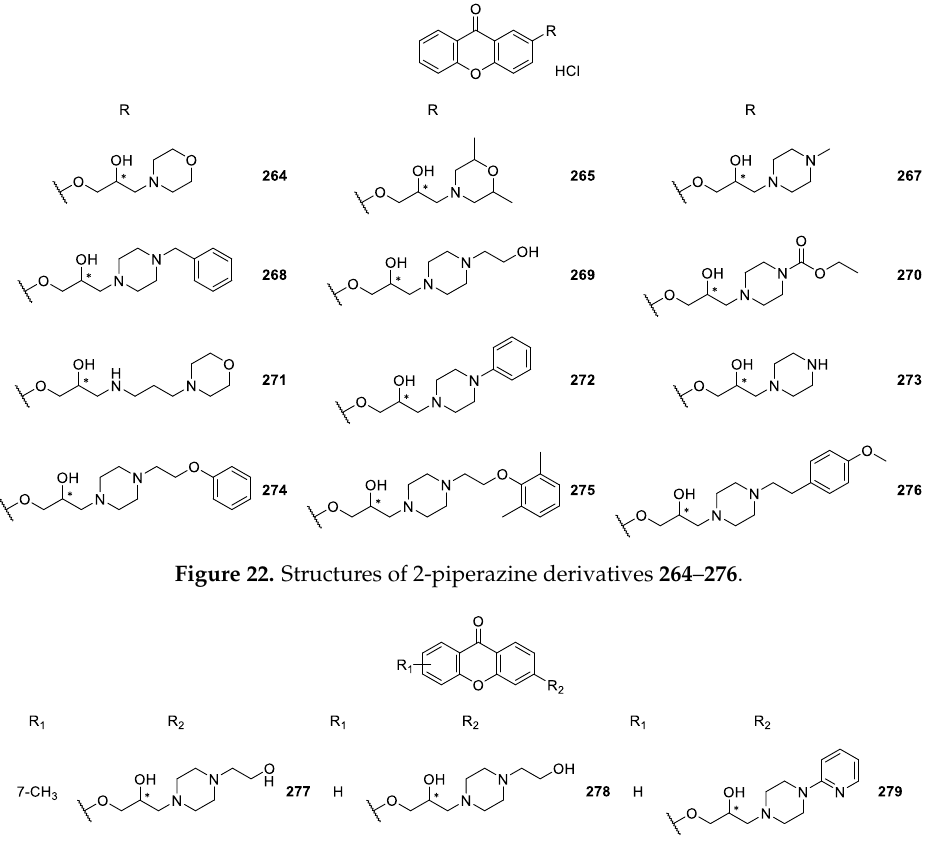
Figure 23. Structures of 3-piperazine derivatives 277 – 279 .